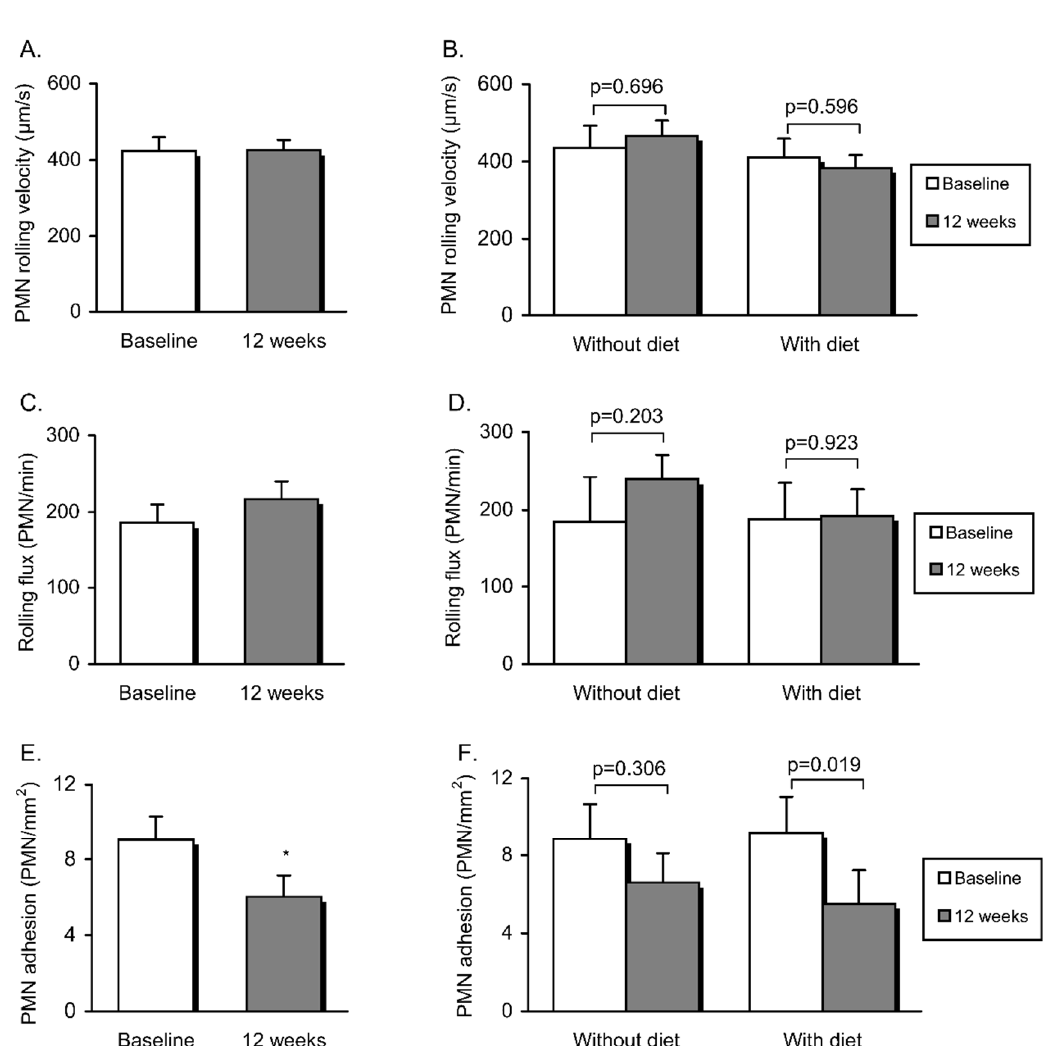
Figure 3. Endothelial function (determined by PMN-endothelial interactions) in the study population before and after non-surgical periodontal treatment and dietary weight loss intervention: PMN rolling velocity ( A , B ), PMN rolling flux ( C , D ) and PMN adhesion ( E , F ). Data are represented as mean + standard error. The whole obese population was compared before and after intervention using a paired Student’s t -test (* p < 0.05). Obese patients undergoing vs. those not undergoing dietary therapy were compared before and after intervention (also using a paired Student’s t -test; differences were considered significant when p < 0.05).